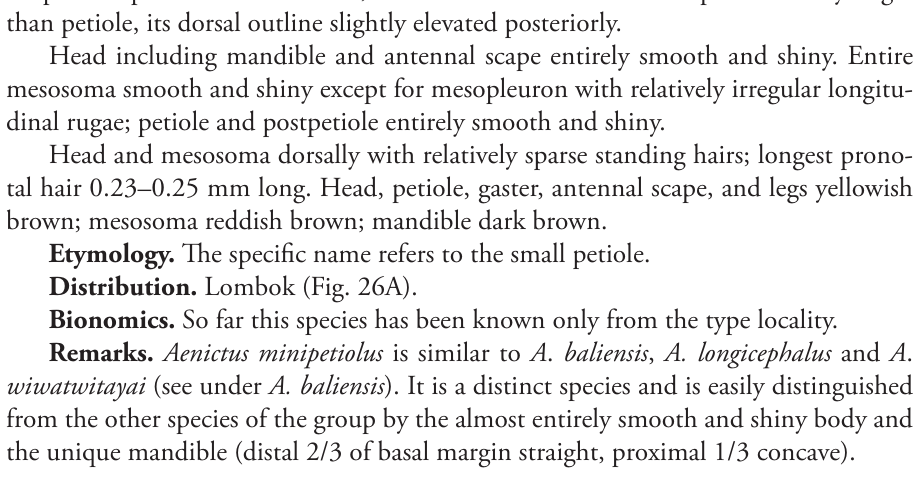
Type material examined. Holotype . PHILIPPINES: Worker from Philippines, Luzon, Mountain Prov., Sagada, Bokong waterfall, 1400 m alt., 19.II.1999, leg.